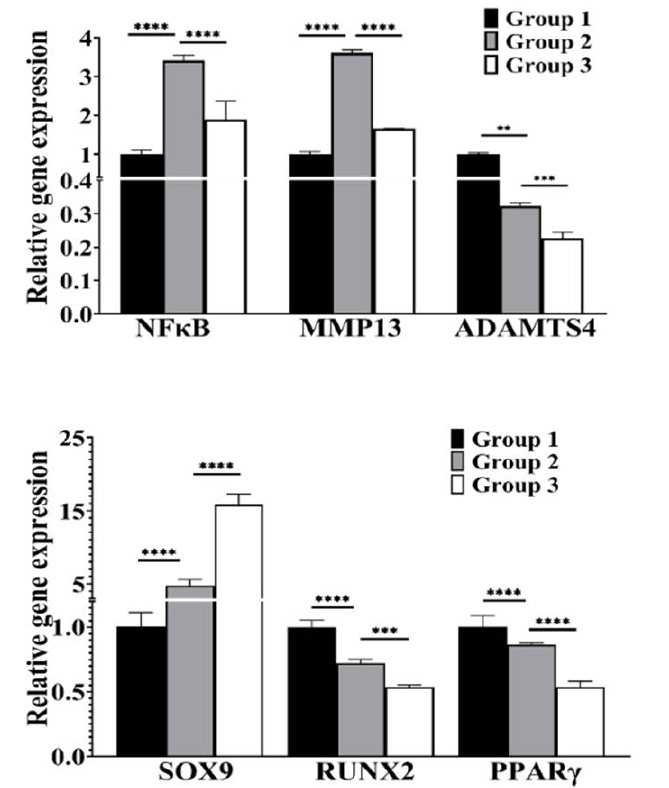
Figure 3. Gene expression analysis of MSCs in hydrogels. Cell homogenates ( n = 10) were prepared from hydrogels; total RNA was extracted, and gene expression of lineage markers and catabolic markers was evaluated by qRT-PCR, and GAPDH was used as a housekeeping gene. Data are shown as the mean ± standard deviation of samples and p -value represents statistical significance (** p < 0.01; *** p < 0.001 and **** p < 0.0001).